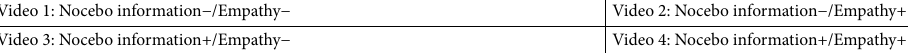
Table 1. Overview of the content of the four videos